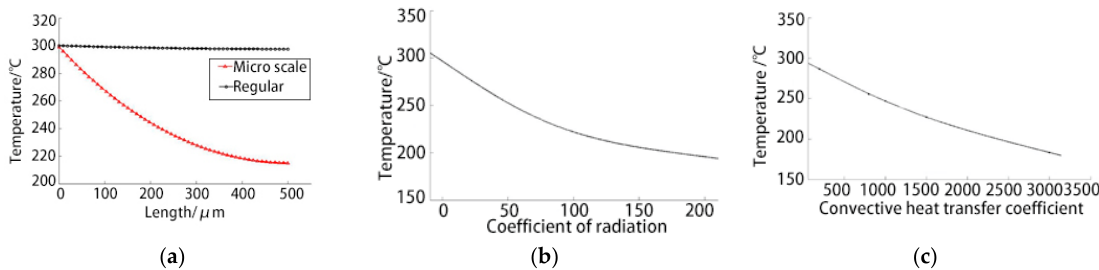
Figure 4. Influence of the heat transfer parameters on the temperature field: ( a ) Comparison of the experimental results;